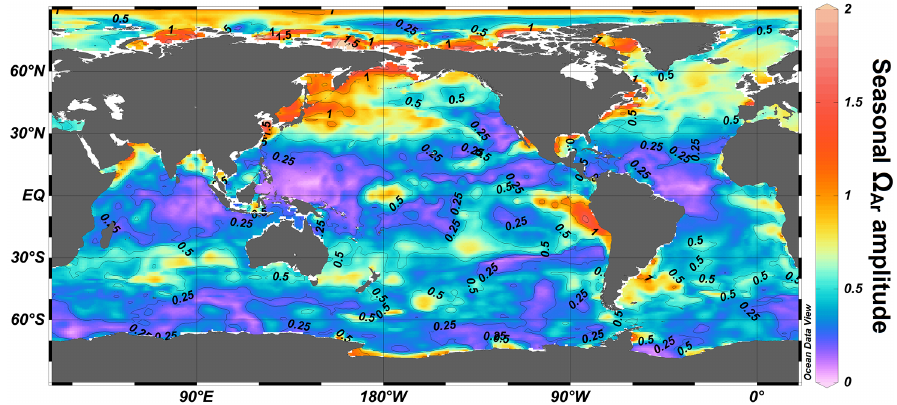
Figure 4. Seasonal (cid:127) Ar amplitudes for the nominal year of 2000. Seasonal amplitudes were calculated as the maximum minus minimum monthly (cid:127) Ar values in each 1 ◦ × 1 ◦ cell (see Fig. S1 for monthly (cid:127) Ar distributions). Table 2. Main characteristics of the six ESMs used in this